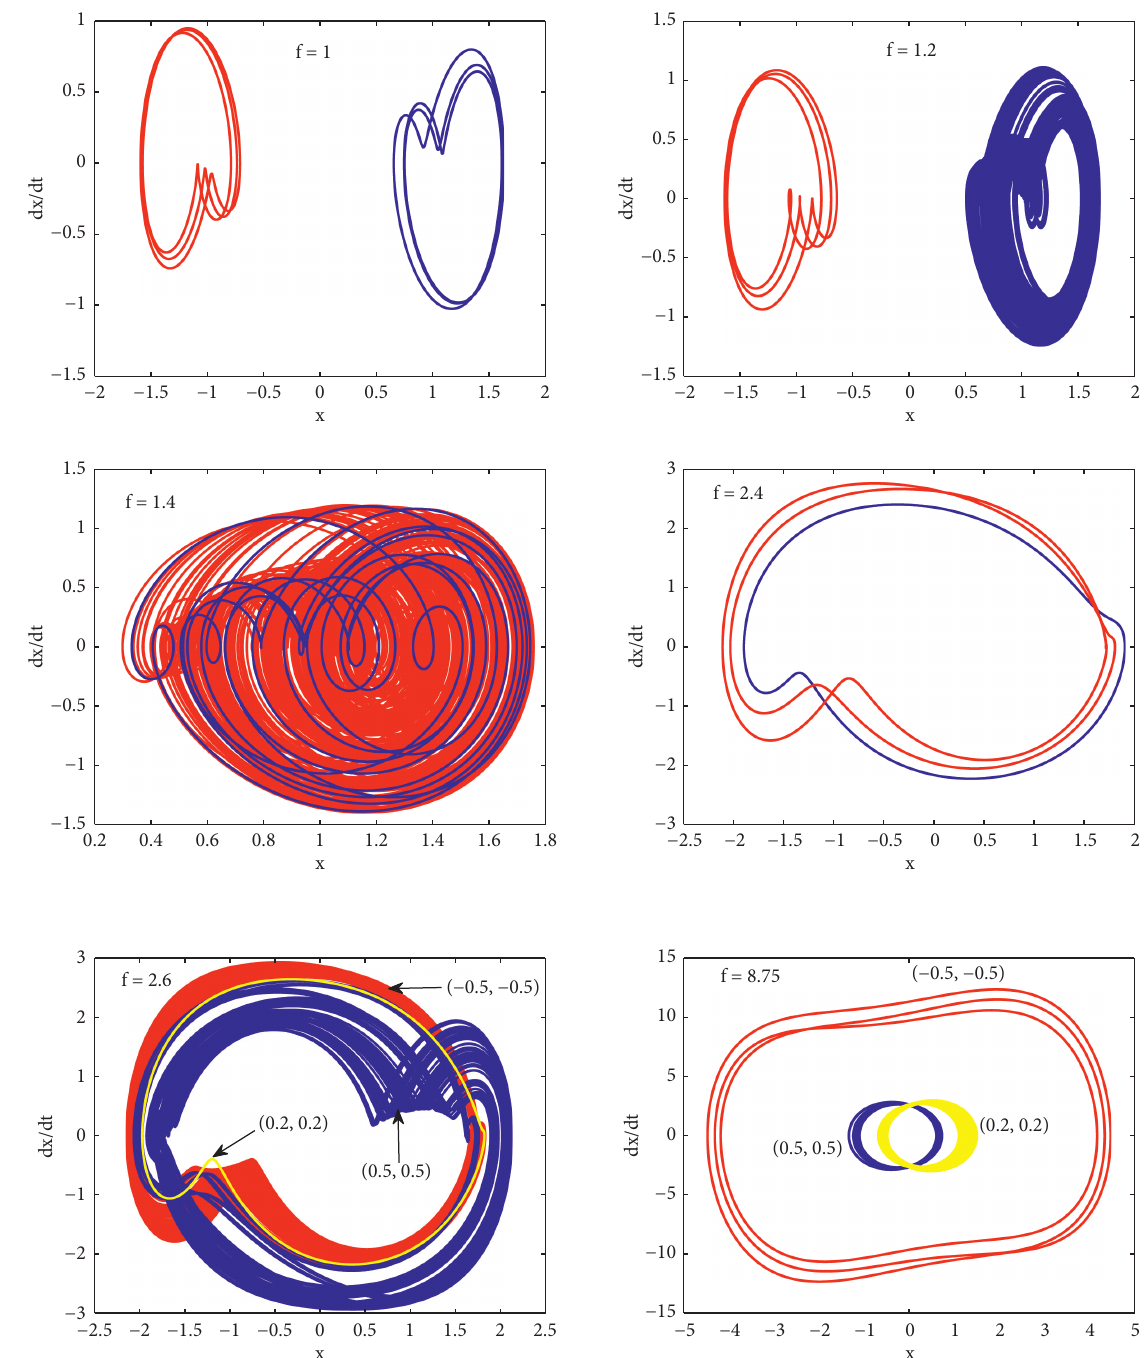
Figure 12: Coexisting behaviors of attractors in a new parametric chemical system (1) with Ω � 3, ω � 1, p � 0 . 005, and α other system parameters are kept